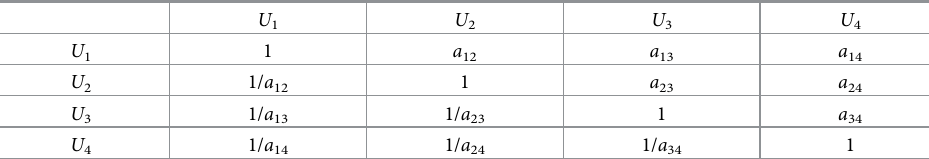
Table 3. Judgment matrix of the criterion layer index.